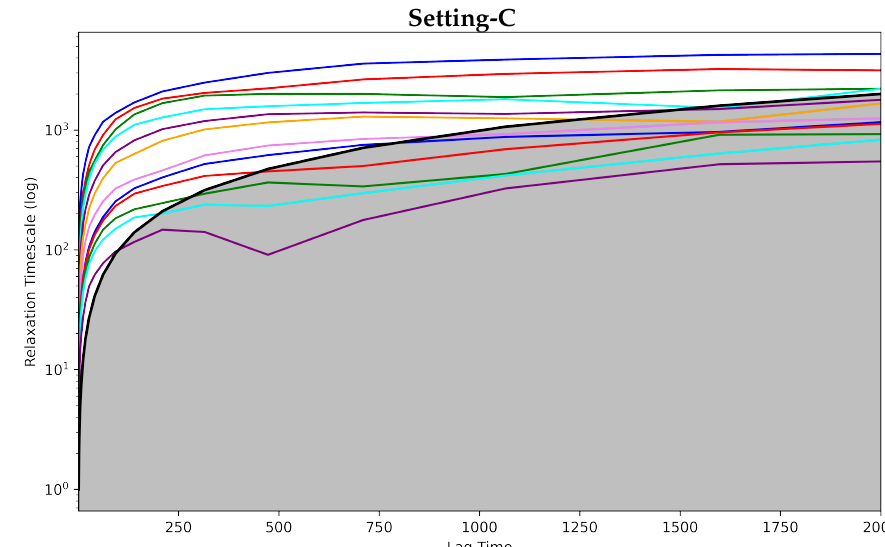
Figure 4. The Convergence Analysis is carried out on each of the antigen-bound antibody MSM models obtained, respectively, from ( top panel) Setting-A, ( middle panel) Setting-B, and (bottom panel) Setting-C. Each drawn curve shows the relaxation timescale of an MSM composed of s states, as s varies from 1 to the total number of states identified. The cutoff region (above which any curve representing a good discretization of the state space should be) is shown in gray.